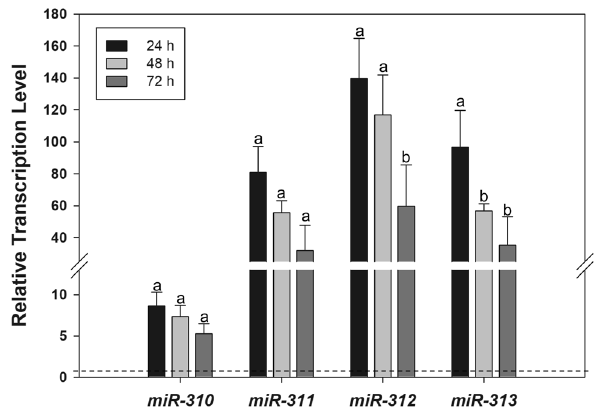
Figure 1. Relative transcription levels of miR-310 , miR-311 , miR-312 , and miR-313 after microinjection of the miR-310s mimics, negative control siRNA (NCsiRNA) mimic, and DEPC-water into 91-R female at 24 h, 48 h, and 72 h post-injection. All levels of miR-310s are given relative to the transcription levels of NC and DEPC- water which were ascribed an arbitrary value of 1 (dashed line). There was no difference between the DEPC and NCsiRNA microinjection groups ( p = 0.229–0.943). Different letters on the bars indicate that the means are significantly different across three time points within each miRNA ( p <